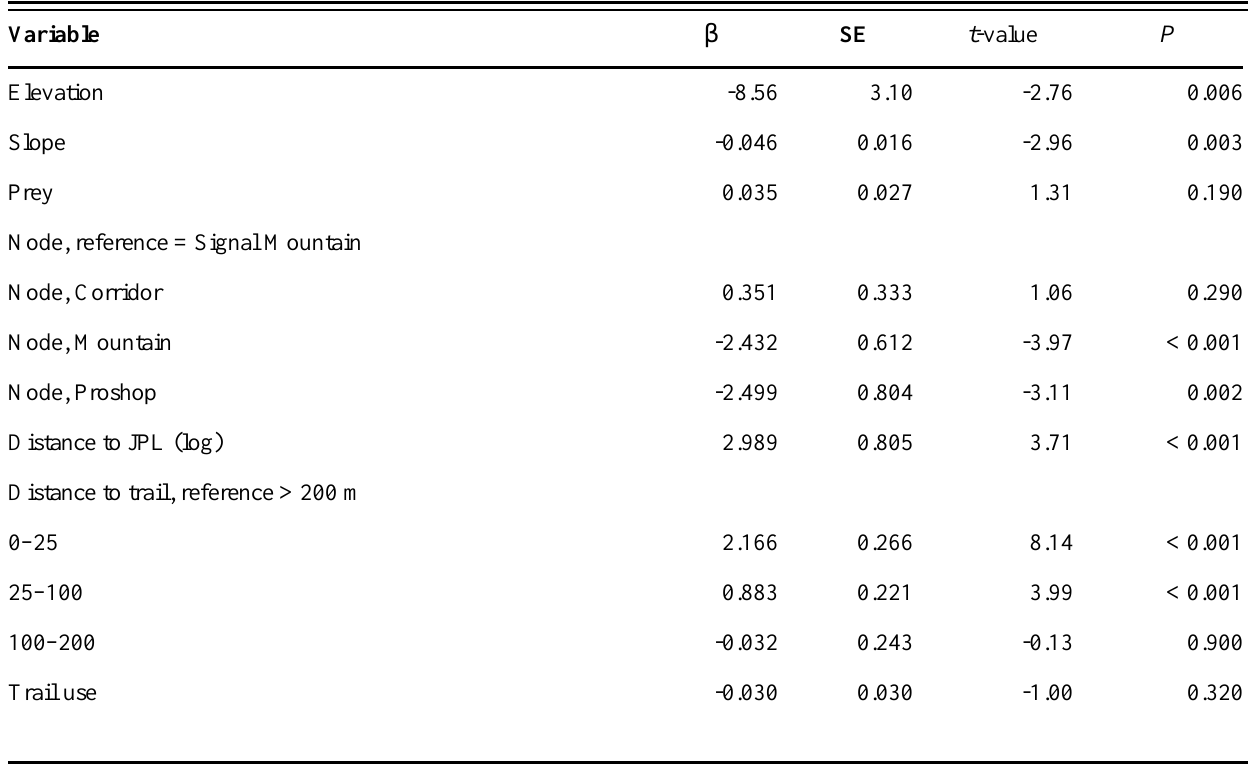
Table 1. Model predicting wolf occurrence using match case-control logistic regression. JPL: Jasper Park